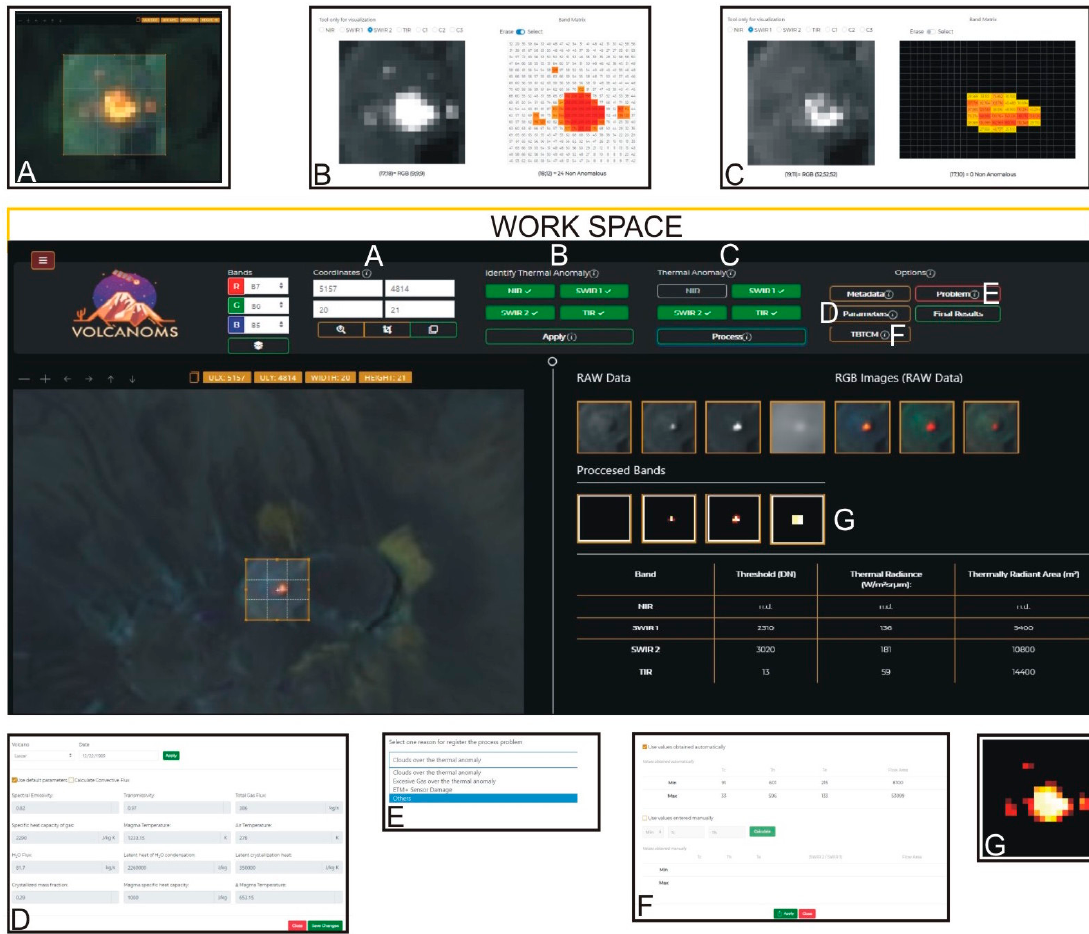
Figure 3. The Volcanic Imagery Processing System (VIPS) workspace. ( A ) Subset from an ROI. ( B ) Modal dialog to select the thermally anomalous pixels. ( C ) Modal dialog to verify the thermally anomalous pixels. ( D ) Modal dialog to enter thermal parameters. ( E ) Modal dialog to report problems/errors from the original image. ( F ) Modal dialog to verify and to iterate manually TBTCM. ( G ) An example of a processed band.